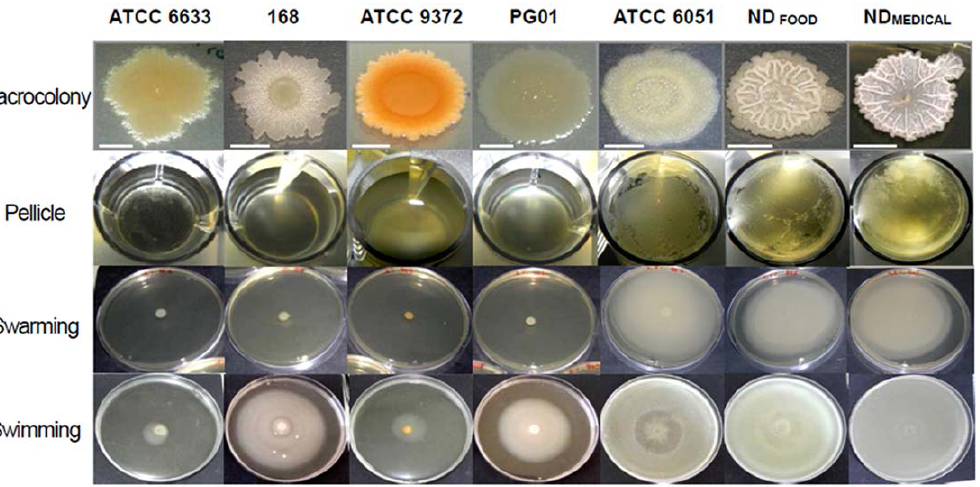
Figure 3. Macrocolony, pellicle, swarming and swimming phenotypes of the seven B.subtilis strains. Macrocolonies grown on TSA medium (1.5% agar) for 72h at 30 u C after a central spot of 5 m l of an overnight bacterial culture in TSB. The scale bar is 5mm. Pellicles formed in 24- well microplates after 48h incubation at 30 u C in TSB. Swarming plates (9 cm diameter) after 24h incubation at 30 u C on TSA semi-solid medium (0.8% agar). Swimming plates (9 cm diameter) after 24h incubation at 30 u C on TSA semi-solid medium (0.25% agar).